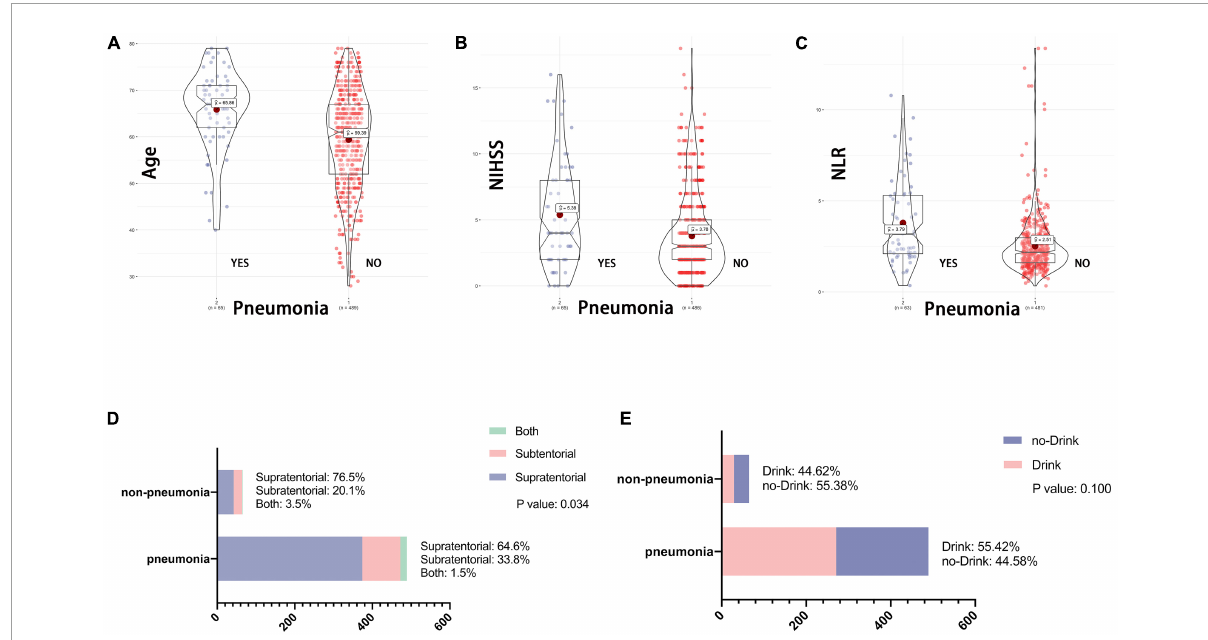
FIGURE5 (A–E) Association between baseline data and SAP. NIHSS, National Institutes of Health Stroke Scale on admission; NLR, Neutrophil to lymphocyte ratio. One of the endpoint of this study is the presence of stroke associated SAP after AIS. As with the variables included in Figure 1 , whether the patient drank at 1 month of follow-up had no effect on the occurrence of SAP. While patient age, NLR, NHISS and stroke location remained statistically different between the two groups.